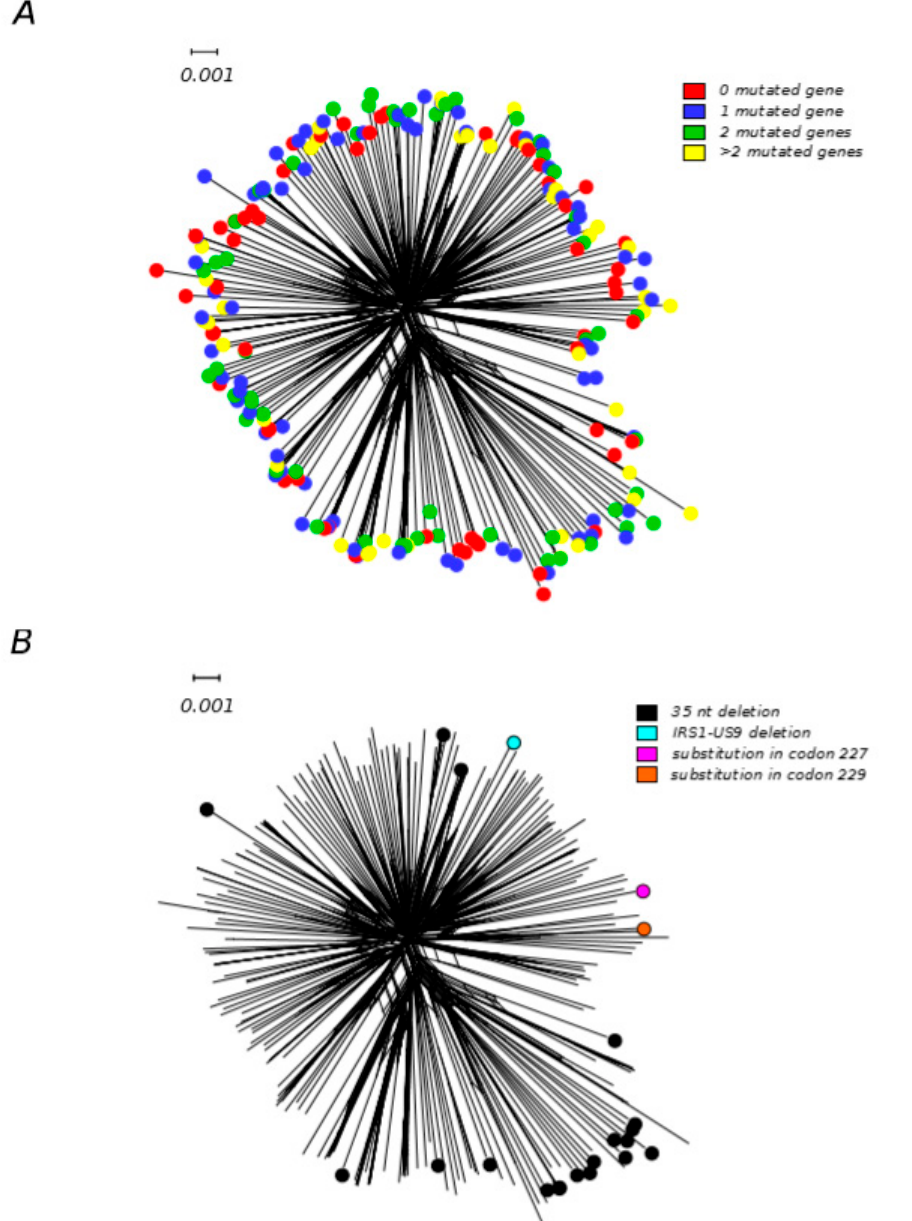
Figure 3. Gene disrupting mutations in HCMV strains. Neighbor–net split network of 233 HCMV genome sequences. ( A ) Strains are color–coded on the basis of the number of mutated genes. ( B ) Strains are color–coded depending on the type of US9 mutation (Supplementary Table S1). Neighbor–net split networks of genomic sequences were constructed with SplitsTree v4.13.1 [81] using uncorrected p–distances and all polymorphic sites, after removing gap sites.